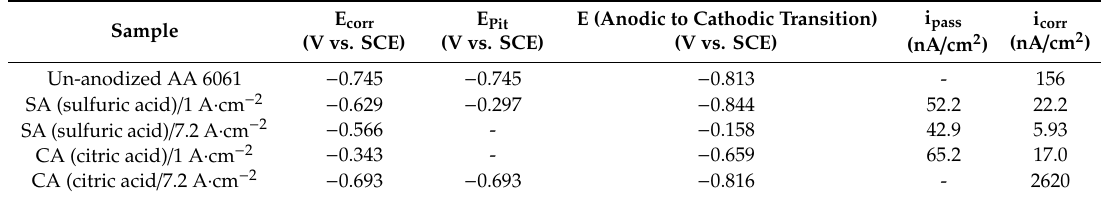
Table 3. Electrochemical parameters using cyclic potentiodynamic polarization of AA 6061 and anodized samples in 3.5 wt.% NaCl